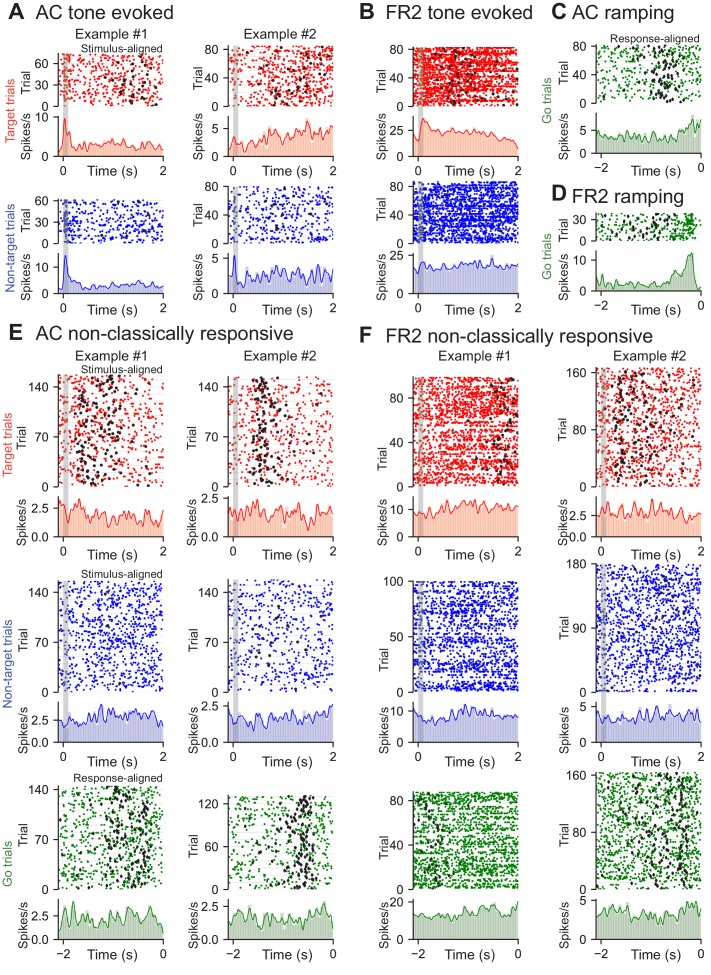
Examples of tone-evoked, ramping, and non-classically responsive cells from AC and FR2.(A) Two example tone-evoked cells recorded from AC. Rasters and PSTHs of target (red) and non-target (blue) trials shown. Stimulus shown as grey bar and black circles represent behavioral response. (Example #1: average evoked spikes on target tones = 0.55, on non-target = 0.92. Example #2: average evoked spikes on target tones = 0.096, on non-target = 0.12; note that example #2 is only non-target tone evoked). (B) Example target tone-evoked cell recorded from FR2. Rasters and PSTHs of target (red) and non-target (blue) trials shown (average evoked spikes on target tones = 0.37, on non-target = 0.20). (C) Example ramping cell recorded from AC. Rasters and PSTH of go trials (green) shown (ramp index = 2.8). (D) Example ramping cell recorded from FR2 (ramp index = 4.9). Rasters and PSTH of go trials (green) shown. (E) Two example non-classically responsive cells recorded from AC. Rasters and PSTH of target (red), non-target (blue), and go (green) trials shown. (Example #1: average evoked spikes on target tones = 0.12, on non-target = −0.12, ramp index = −0.85; ptone <0.001, pramp = 0.010, 2000 bootstraps; Example #2: average evoked spikes on target tones = −0.020, on non-target = −0.038, ramp index = 1.1; ptone <0.001, pramp = 0.004, 2000 bootstraps). (F) Two example non-classically responsive cells recorded from FR2 (Example #1: average evoked spikes on target tones = 0.081, on non-target = −0.15, ramp index = 1.4; ptone <0.001, pramp = 0.019, 2000 bootstraps; Example #2: average evoked spikes on target tones = 0.046, on non-target = −0.070, ramp index = 1.8; ptone <0.001, pramp = 0.033, 2000 bootstraps). Rasters and PSTH of target (red), non-target (blue), and go (green) trials shown.